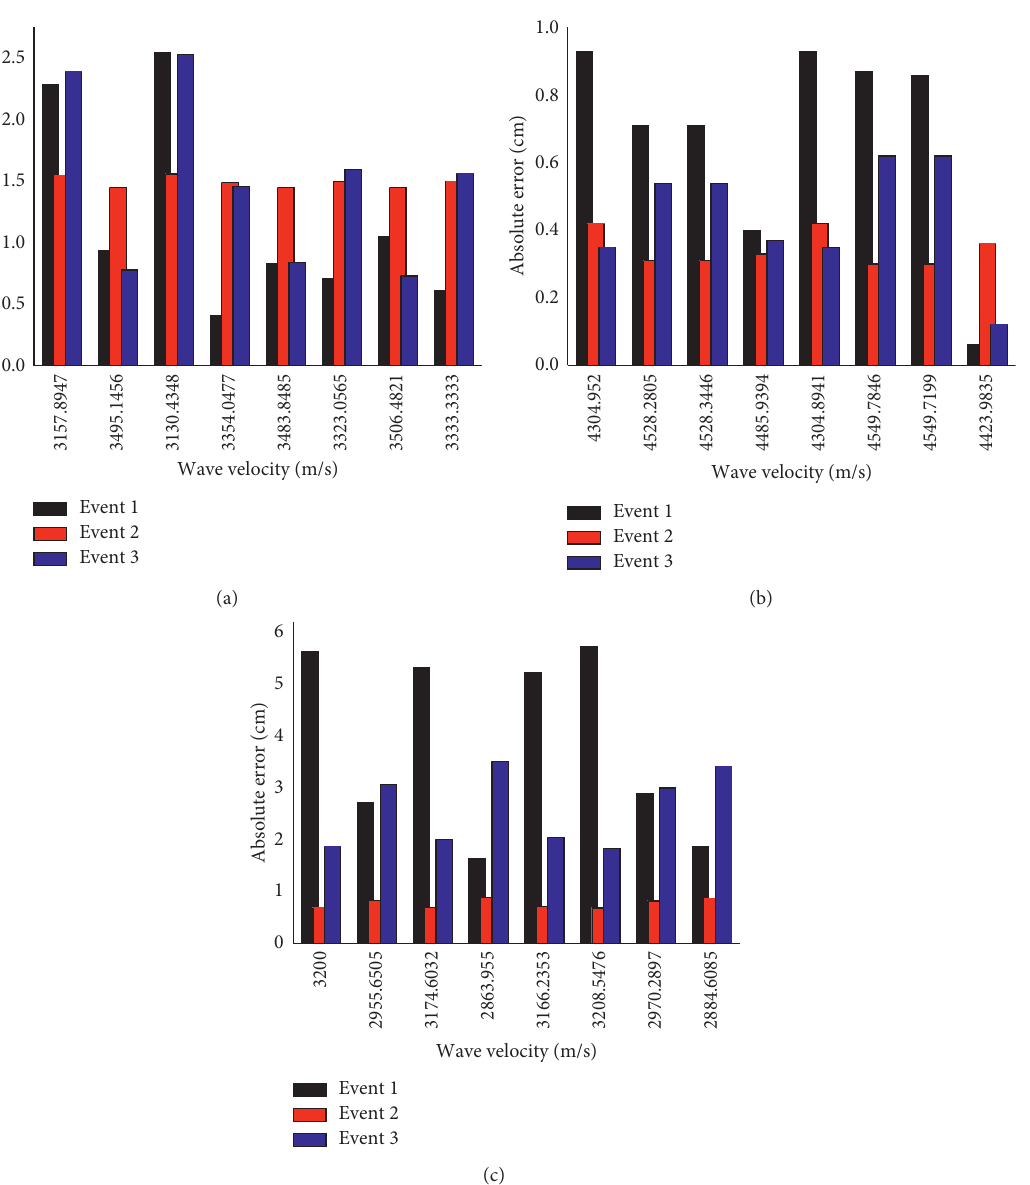
Figure 4: The histogram of velocity and absolute error for rod-shaped rock. (a) G376. (b) GAM. (c)